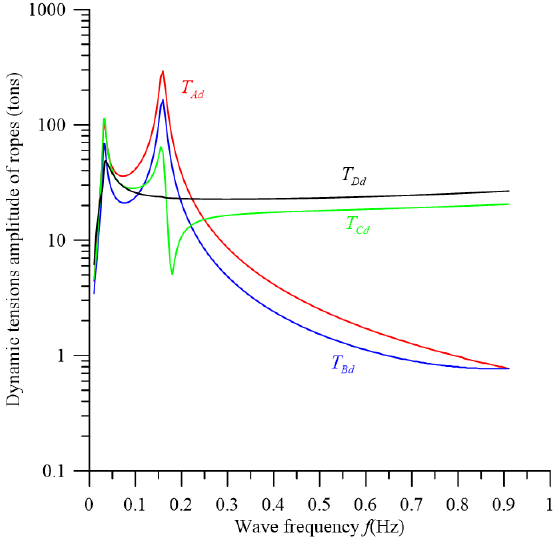
Figure 12. Spectrum of rope tension ( L C = L D = 60 m β P = β T = 0.1). Figure 14a demonstrates the dynamic tension spectrum with L C = 140 m and L D = 60 m. In Figure 11a, with the rope lengths L C = L D = 60 m, the maximum dynamic ten- sion T Ad = 84.56